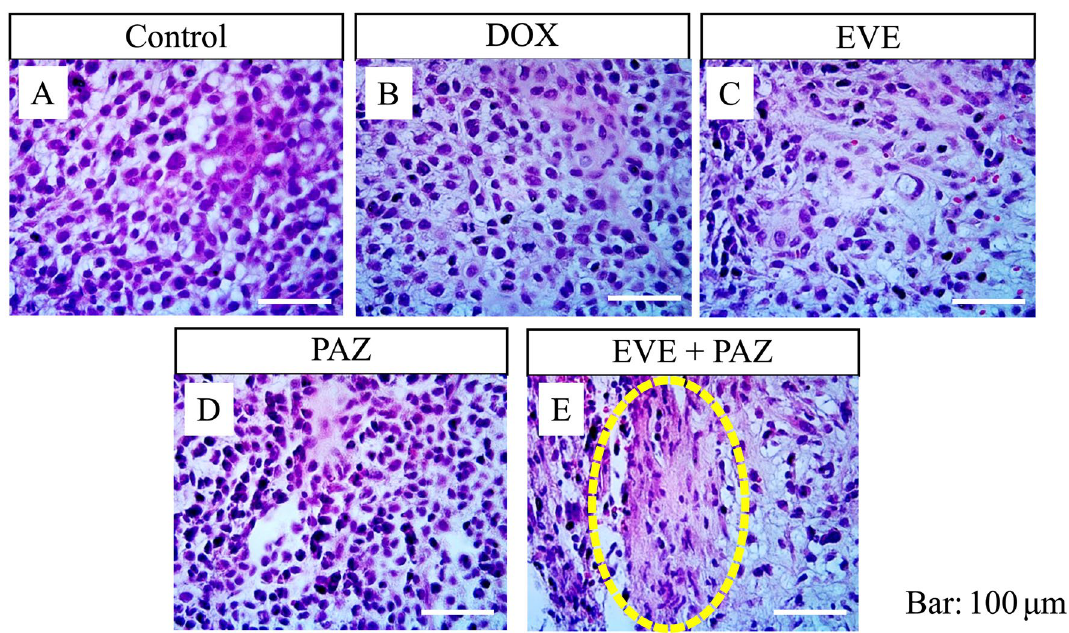
Figure 4. Efficacy of treatment of the osteosarcoma PDOX mouse model on tumor histopathology. Hematoxylin & eosin staining. ( A ) Group 1 treated with PBS; ( B ) Group 2 treated with DOX; ( C ) Group 3 treated with EVE-alone; ( D ) Group 4 treated with PAZ-alone; ( E ) Group 5 treated with the combination of EVE and PAZ. Yellow arrows indicate necrotic areas within the tumor. Scale bars are 100 μm.